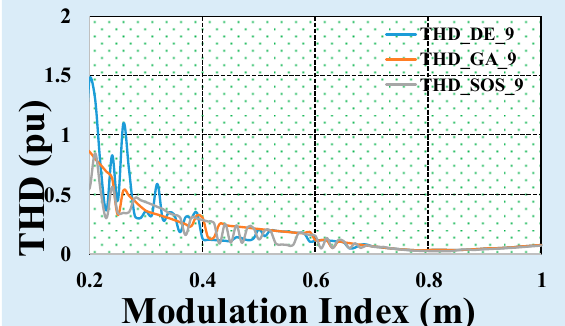
Figure 8. THD comparison with DE and GA.